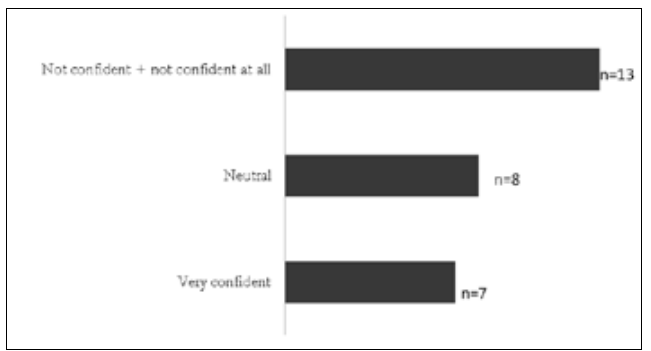
Fig. 2. Confidence levels of therapists when selecting assessments and providing therapy to bi/multilingual children with speech difficulties.